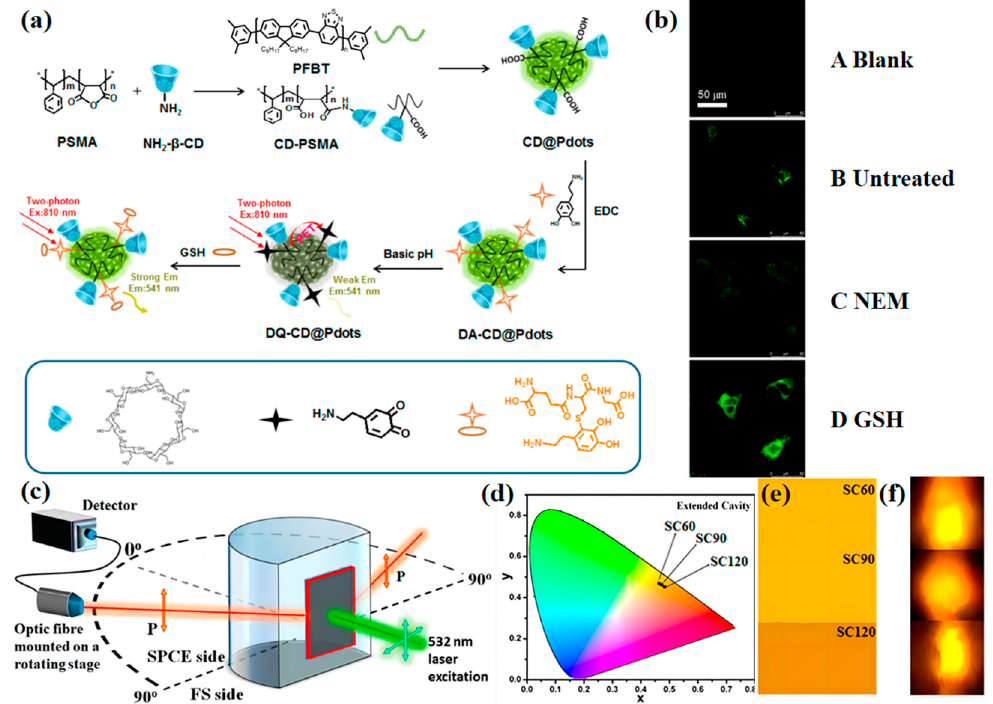
Figure 3. ( a ) Schematic Illustration of the Designed Two-Photon Hybrid Pdots for GSH Sensing. Adapted with permission from [45]. ( b ) Fluorescence microscopic images of ( A Blank ) HeLa cells only, ( B Untreated ) HeLa cells treated with DQ-CD@Pdots, ( C NEM ) HeLa cells treated with NEM as well as DQ-CD@Pdots nanocomposites, and ( D GSH ) HeLa cells treated with GSH as well as DQ-CD@Pdots nanocomposites. Adapted with permission from [45]. ( c ) Optical setup of the SPCE Framework. Adapted with permission from [46]. Fluorescence emission intensities for Ag-SCs (SC60, SC90, and SC120) architectures represented by ( d ) CIE chromaticity plots, ( e ) shade cards, and ( f ) smartphone camera images. Adapted with permission from [46].